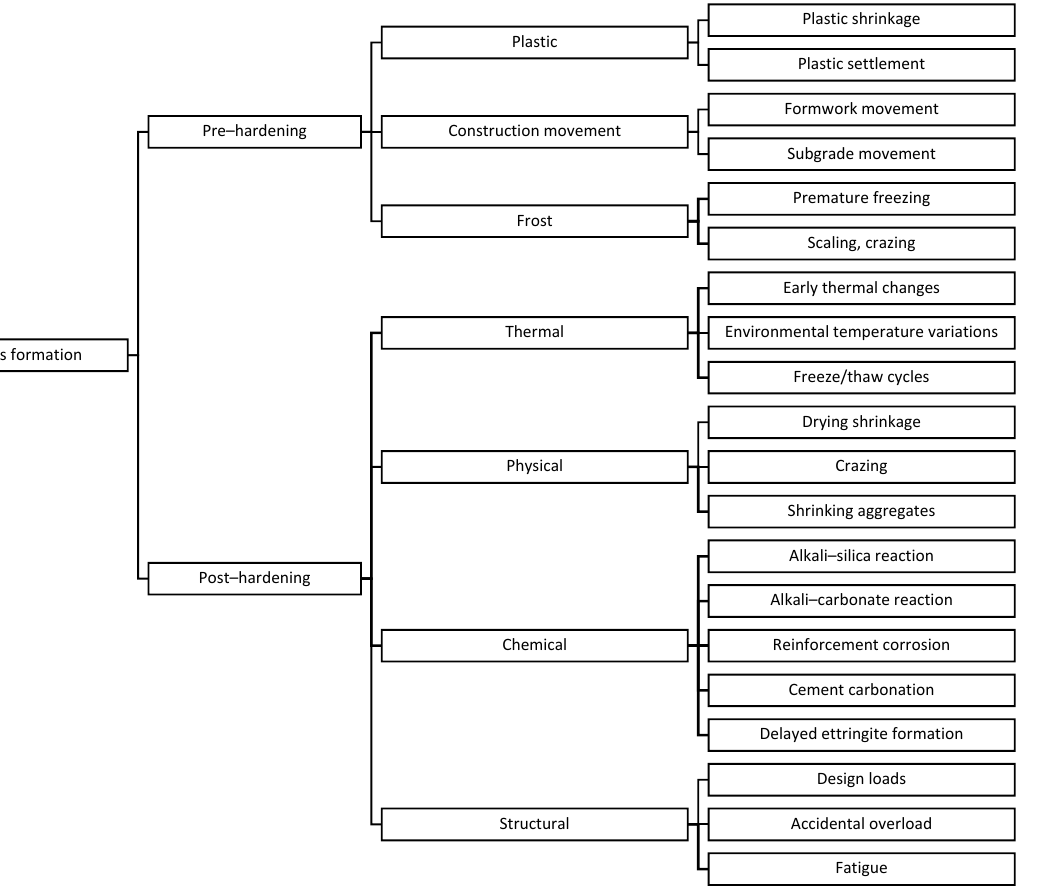
Figure 1. Factors leading to the formation of different types of cracks in concrete. Elaborated from [14,15,24].